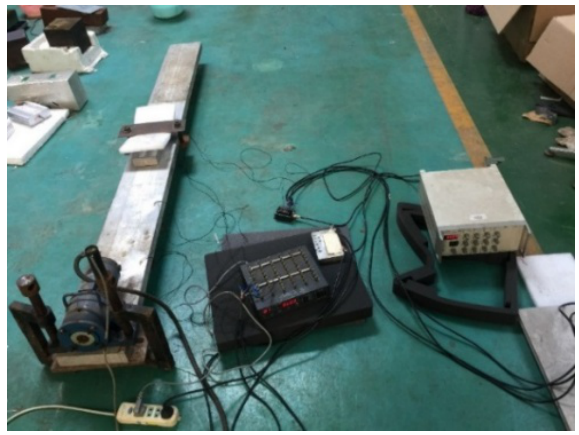
Figure 6. Vibration stress relief experiment.